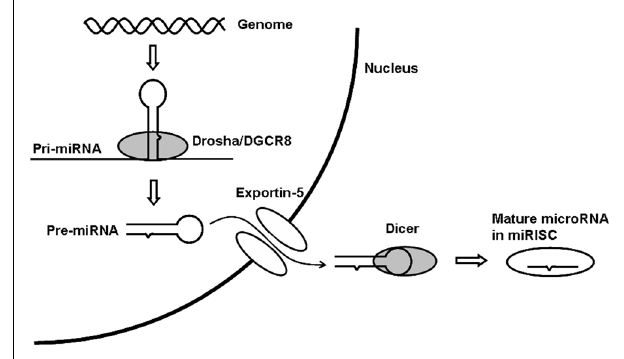
FIGURE 1 | miRNA biogenesis pathway. miRISC, microRNA-induced silencing